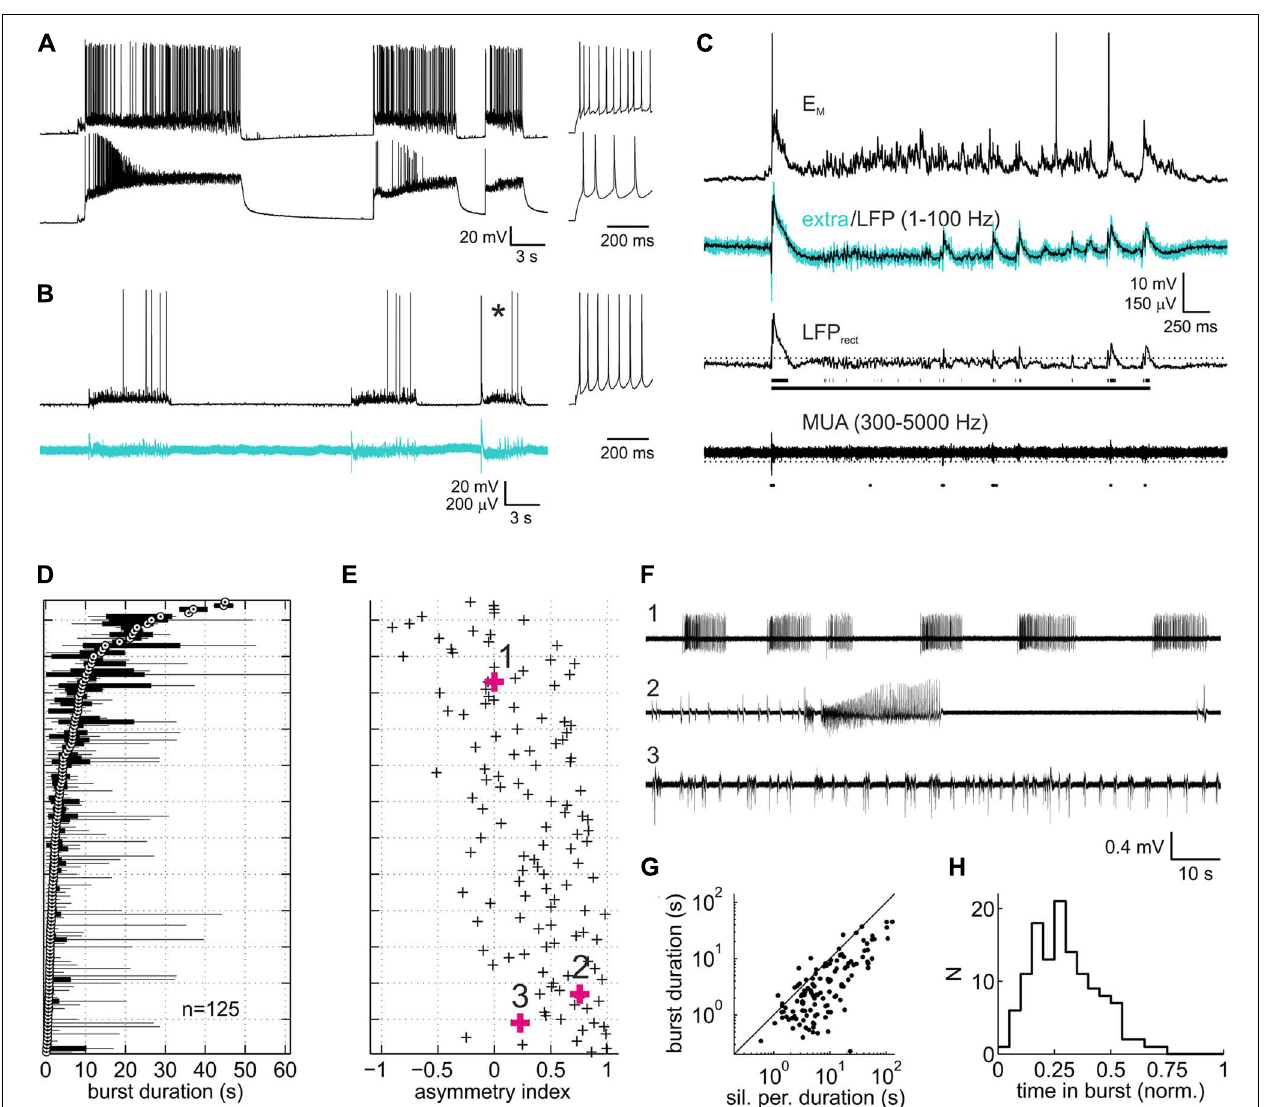
Materials and Methods for more detail on burst detection). Bottom trace, highpass filtered extracellular signal containing multiunit activity. Dots below the trace are the action potentials detected via a threshold (dotted line), which in the example shown was at − 4.4 standard deviations of the base line noise. (D) Box and whisker plot of burst duration. Each sample represents a recording from one culture under control (drug-free) condition ( n = 125, pooled from all experiments). Data are sorted according to the median (white circle with black central dot). Black bars depict the interquartile range, and black lines extend to the full range of burst durations in the recordings. (E) Asymmetry index (ai, see Methods) of burst duration of the corresponding recordings. Positive/negative values indicate the presence of a few disproportionately long/short bursts (relative to the median). (F) Representative extracellular recordings (broadband signal) marked by bold symbols and numbers in (B) . (G) Plot of median burst duration vs. median of silent period duration for each of the recordings shown in (D) and (E) . Solid line is the identity line. (H) Distribution of proportion of time in